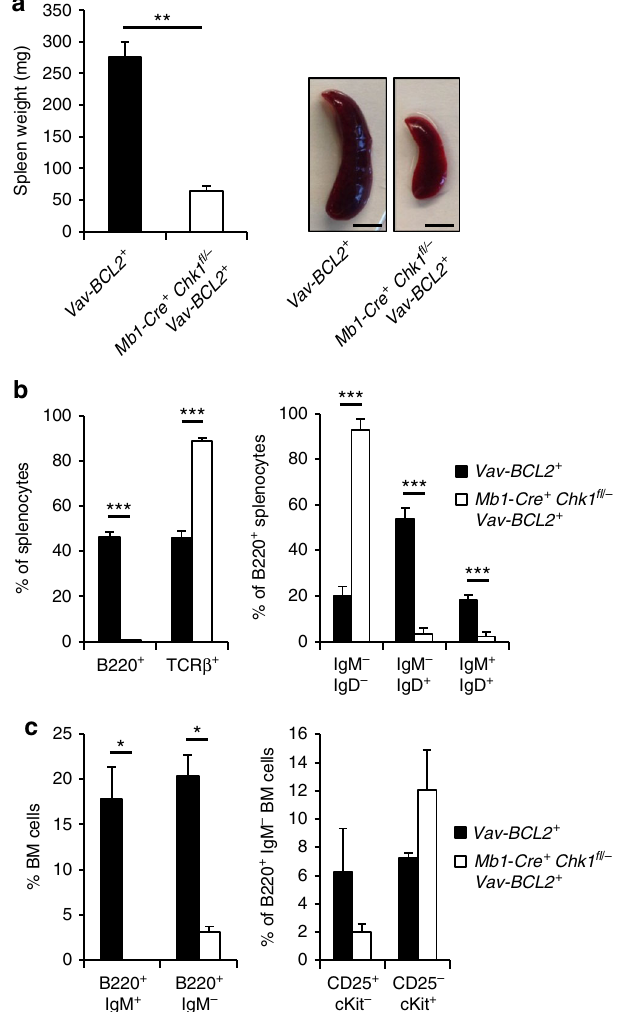
Fig. 4 Inhibition of BCL2-regulated cell death fails to restore B cell development in the absence of CHK1. a Spleen weight and representative pictures (scale bar = 5 mm) of spleens of 6 – 8 weeks old mice of the indicated genotypes. b Relative distribution of splenic B cells (B220 + ) and T cells (TCR β + ) as well as different B cell subsets based on IgM and IgD expression of the indicated genotypes is shown. c Distribution of bone marrow B cell subsets. Bars represent means of n = 4 Vav-BCL2 + and n = 5 Mb1-Cre + Chk1 fl / − Vav-BCL2 + animals ± S.E.M. * p < 0.05, ** p < 0.01, *** p < 0.001 using unpaired Student ´ s t